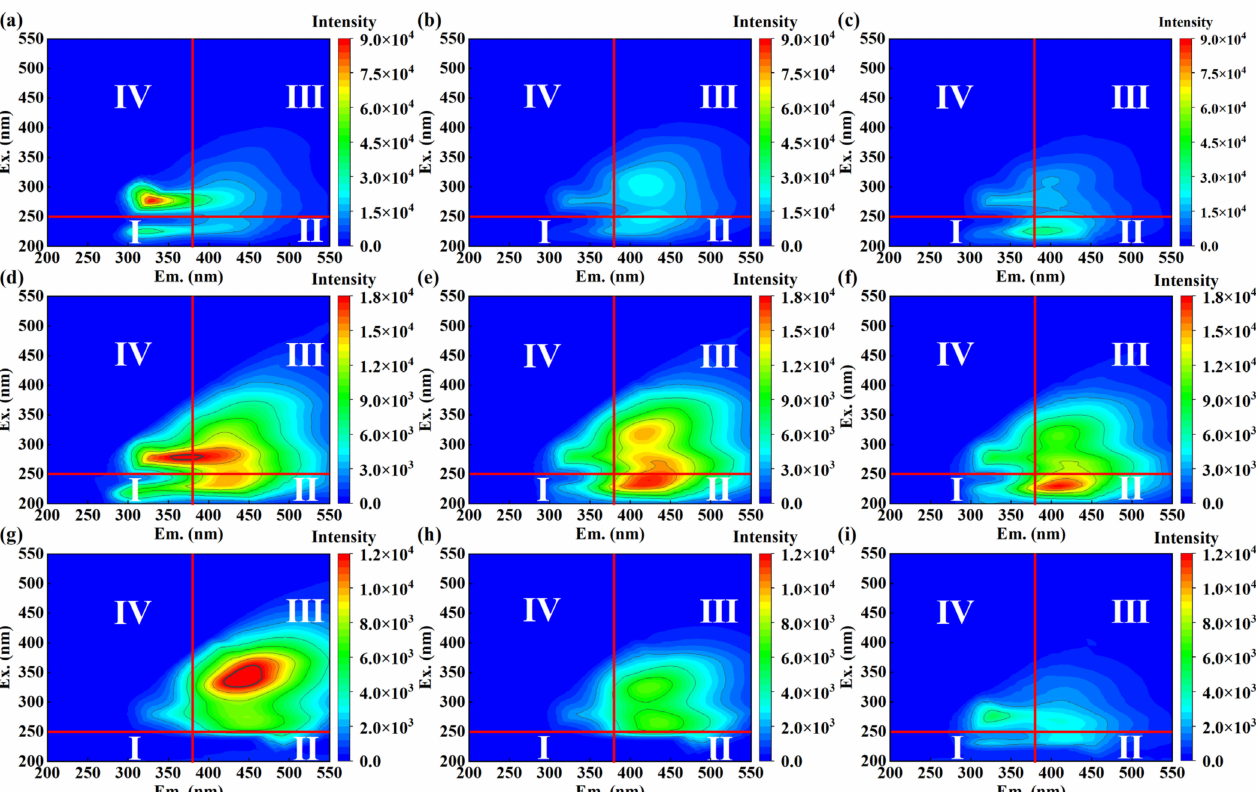
Figure 6. EEM of swine wastewater treated by Ti 4 O 7 anode at 50 mA/cm 2 current density: ( a – c ) are pristine sample I, 30 min treated sample I and 120 min treated sample I, respectively. ( d – f ) are pristine sample II, 30 min treated pristine sample II and 120 min treated sample II, respec- tively. ( g – i ) are pristine sample III, 30 min treated sample III and 120 min treated sample III,